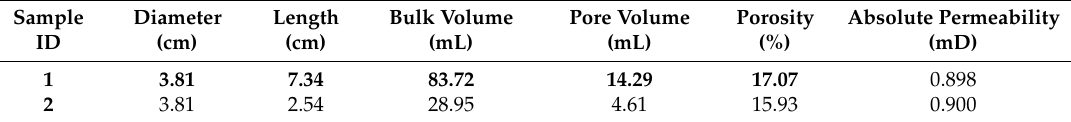
Table 1. Core samples properties.